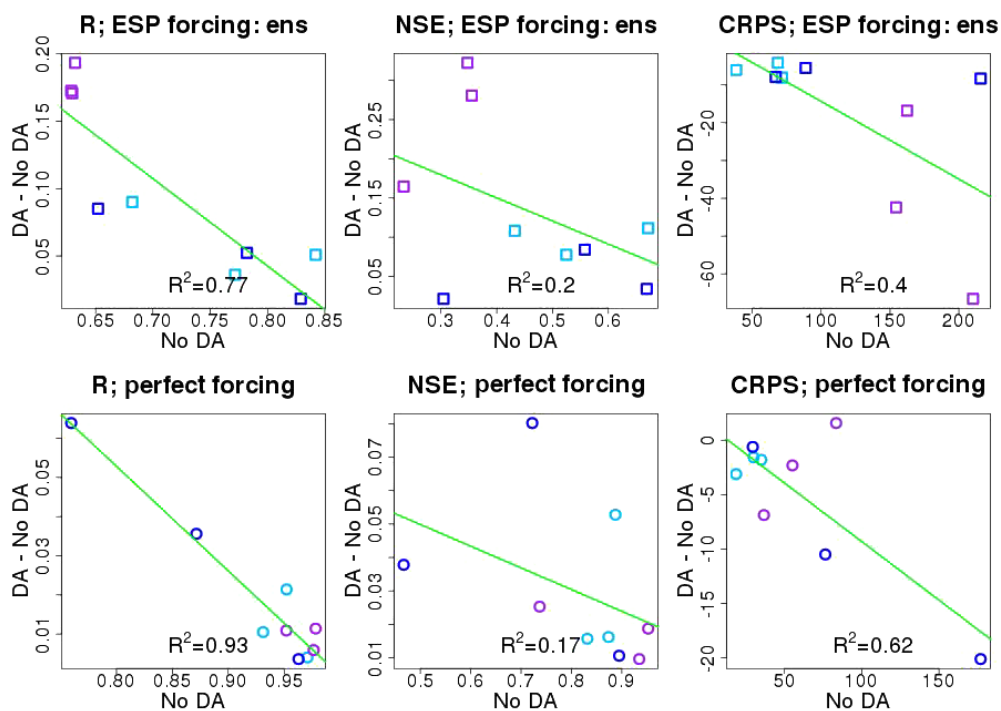
Figure 6. Incremental change in evaluation statistics for ESP and perfect forcing forecasts using percentile-based interpolation for the nine case basins. R is the linear (Pearson) correlation coefficient, NSE is the Nash–Sutcliffe efficiency, and CRPS is the continuous ranked probability skill score.